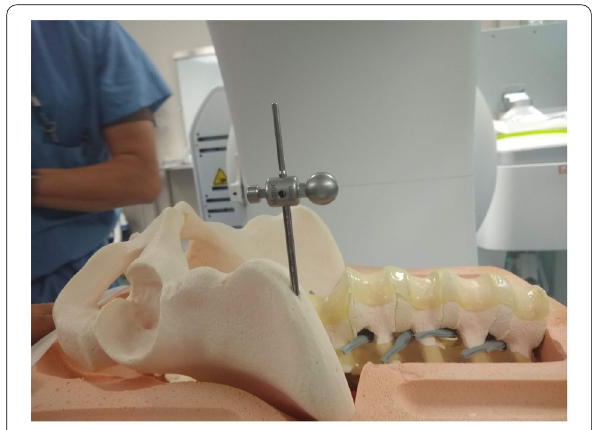
Fig. 1 Lateral view of pin placement for attachment of the robot to the